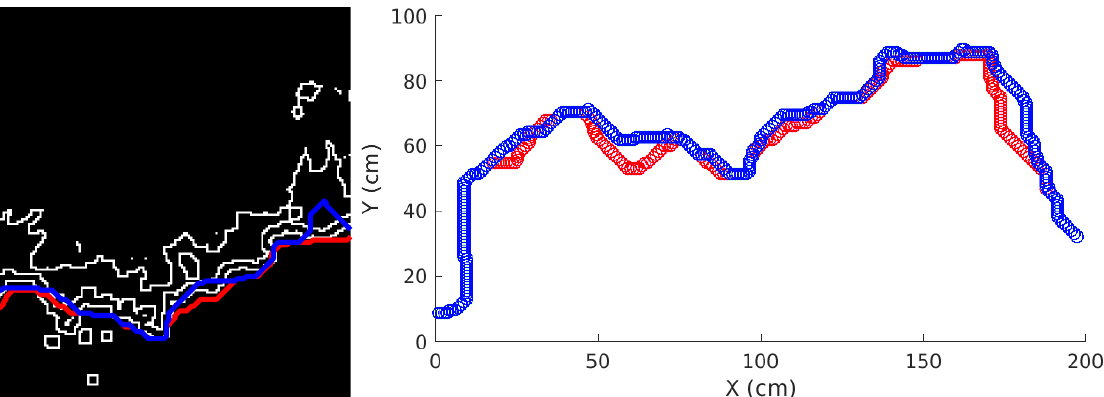
Figure 9. ( Left ): Sample Crawler results for frames at successive time steps overlaid on a portion of the middle third of the right plot of Figure 8. ( Right ): Crawler results for two successive frames converted to ( x , y ) coordinates with physical axes. The red and blue points are the result of Crawler at the successive time